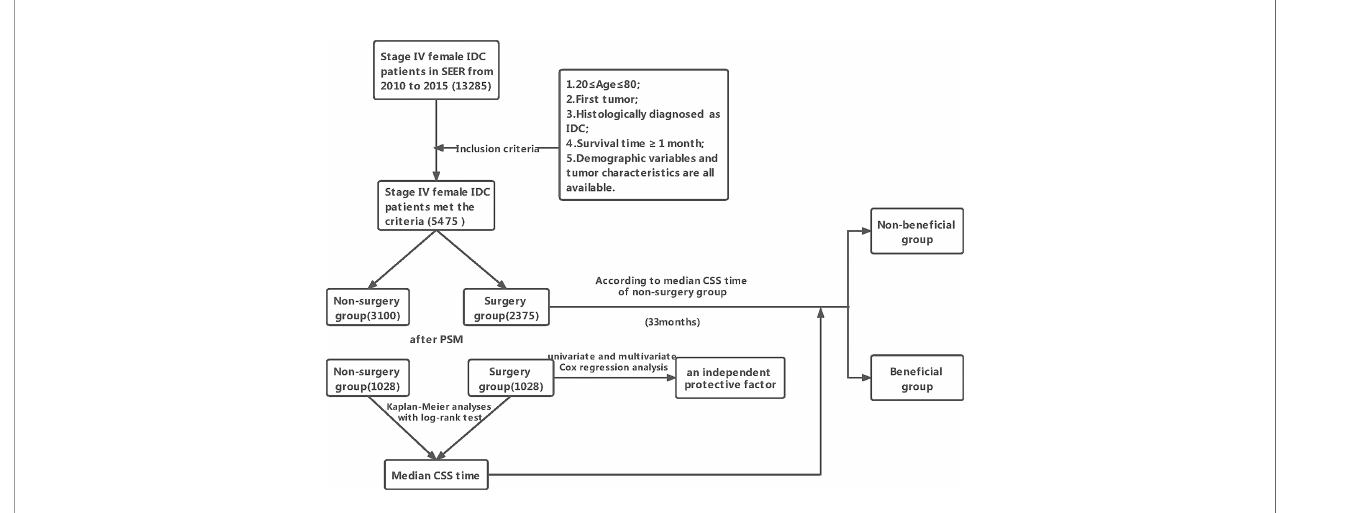
FIGURE 1 | General fl owchart of this